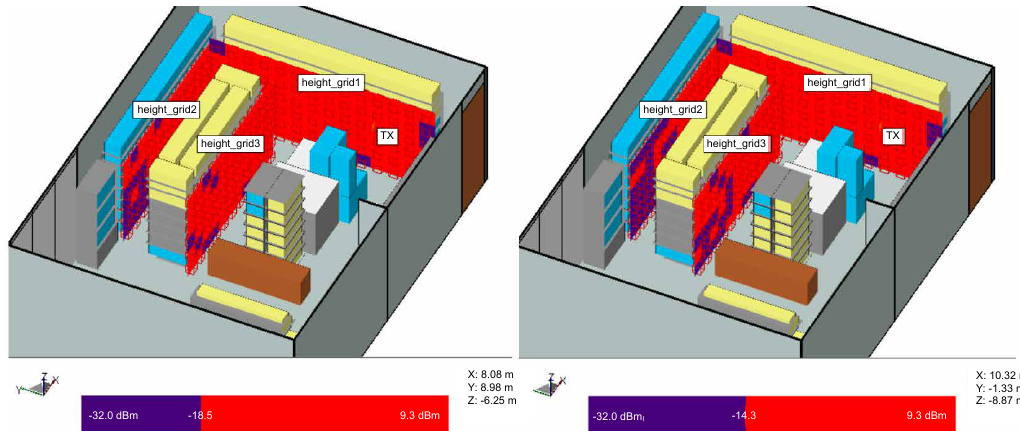
Figure 7. Power distribution for simulation model with mixed products on the shelves and vertical receiver grid, Higgs 2 ( right ) and Higgs 4 ( left